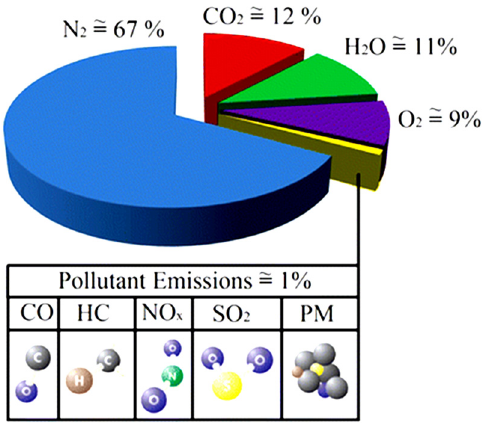
Figure 2. Volumetric composition of typical diesel engine exhaust gas [38].